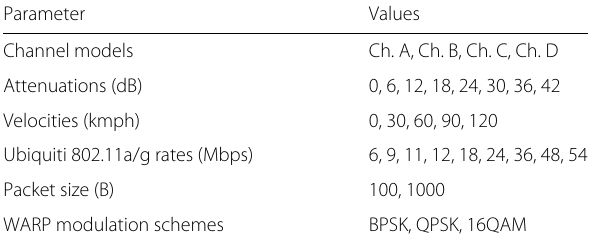
Table 1 Transmission modes and channel emulator